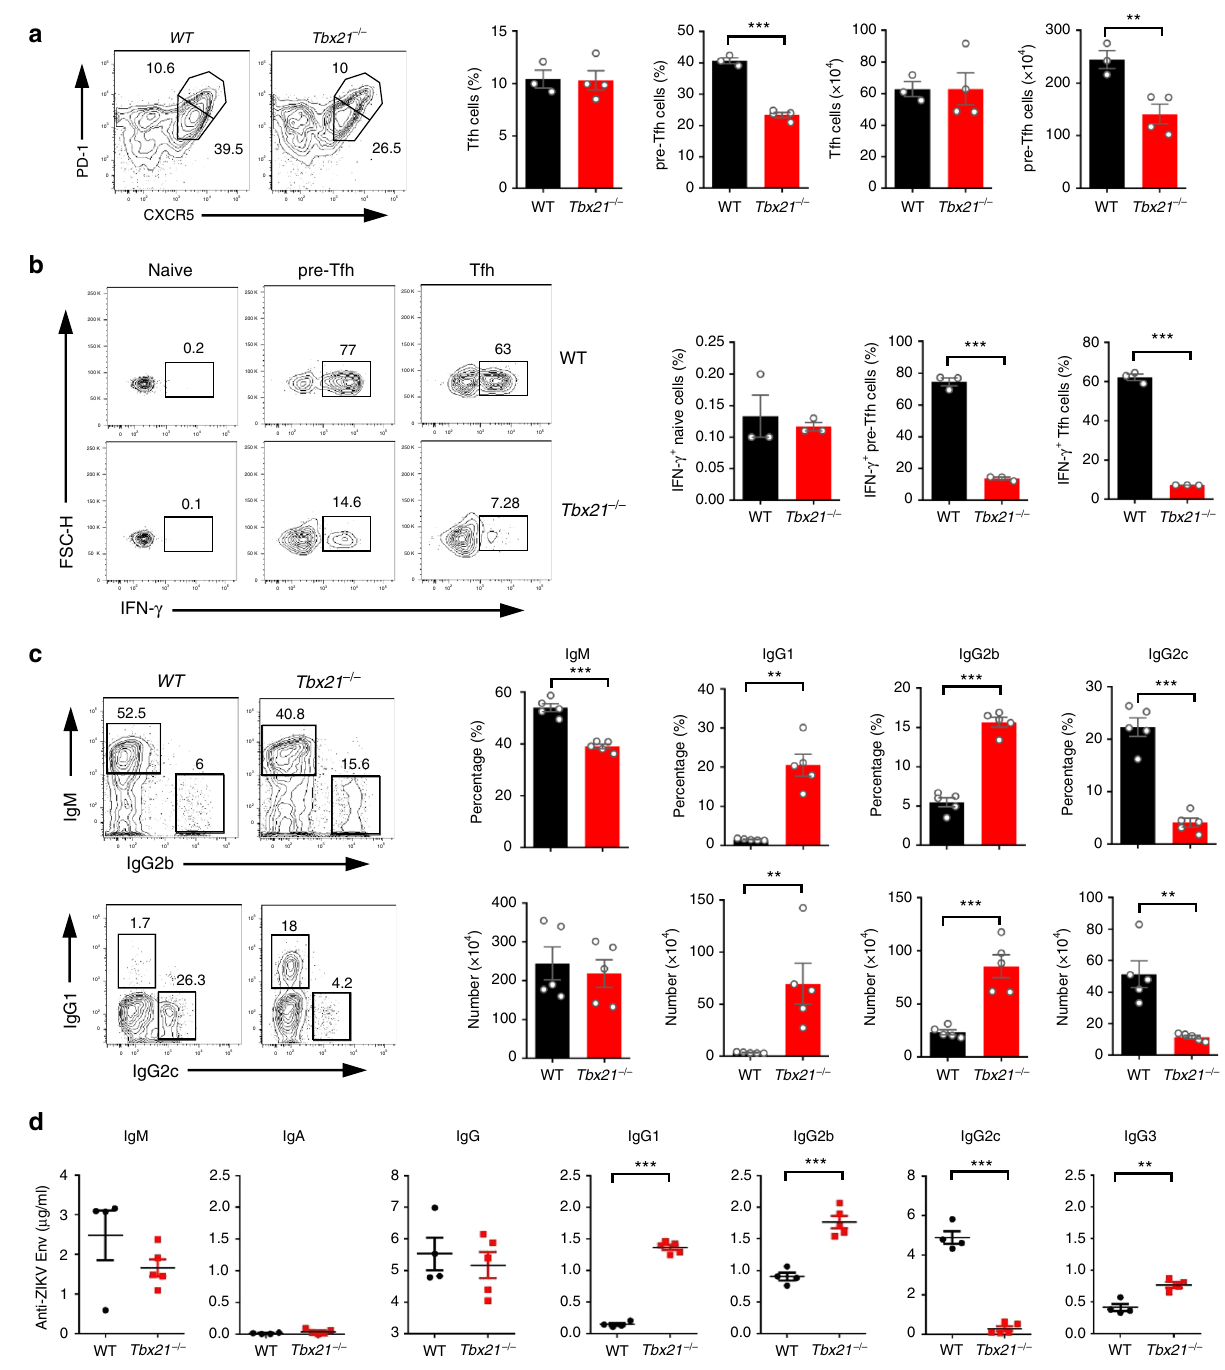
Fig. 5 T-bet is essential for Th1-like Tfh cell differentiation and IgG2c antibody class switching. a – d Wild-type (WT) mice and Tbx21 − / − mice were infected by ZIKV with anti-IFNAR1 blocking antibody. Splenocytes were collected for measurement of Tfh cell on 7 dpi and antibody-producing B-cell responses on 14 dpi, and sera were collected for antibody responses on 14 dpi ( n = 3 – 5 for each group). a Representative fl ow cytometry plots of CXCR5 high PD-1 high cells and CXCR5 medium PD-1 medium in CD4 + CD44 high CD62L low T cells were presented as Tfh cells and pre-Tfh cells (left panel); bar graphs summarized the percentages and numbers of cells in each group. b Representative fl ow cytometry plots of IFN- γ staining in CD4 + CD44 low naive cells, CXCR5 medium PD-1 medium pre-Tfh cells and CXCR5 high PD-1 high Tfh cells (left panel); the percentages of IFN- γ + cells in each group were summarized in bar graphs (right panel). c Representative fl ow cytometry plots of IgM, IgG1, IgG2b, and IgG2c staining of IgD low B cells (left panel); bar graphs summarized the percentages and numbers of cells in each group. d The concentrations of ZIKV envelope speci fi c IgM, IgA, total IgG, IgG1, IgG2b, IgG2c, and IgG3 antibodies were measured by ELISA. The summary data were presented as mean ± SEM. Statistical differences were determined by Student ’ s t test and p values were indicated by ** p < 0.01, or *** p < 0.001. Data shown represent two ( d ) or at least three ( a – c ) independent experiments. Source data are provided as